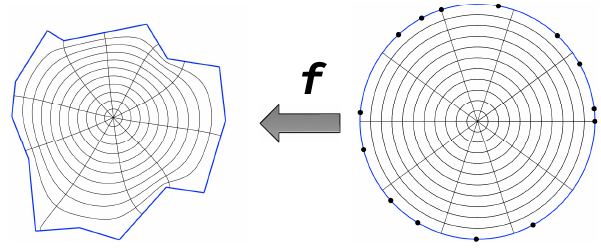
Figure 3. Schwarz–Christoffel mapping for a single-connected